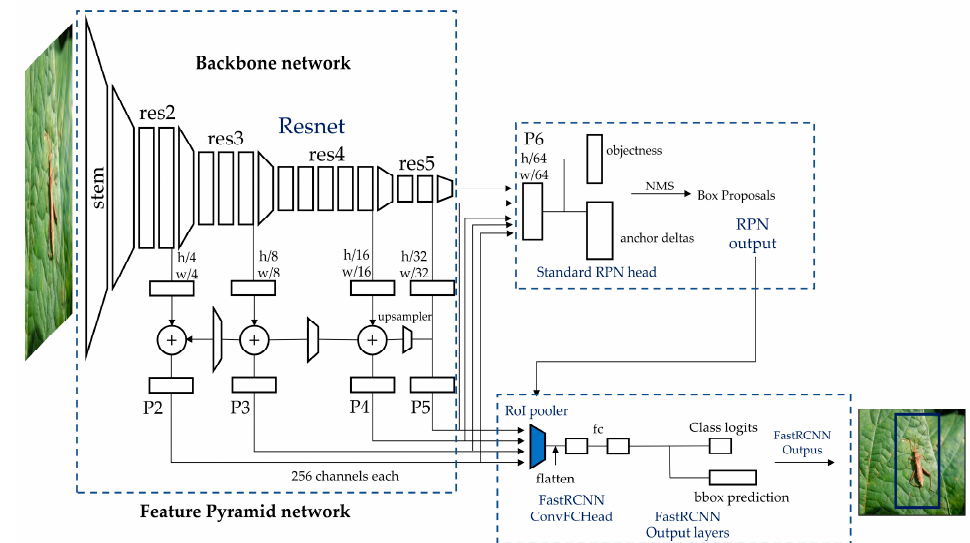
Figure 4. Detectron2 architecture. Detectron2 consists of a Feature Pyramid Network (FPN), Region Proposal Network, RoI Heads, and RoI pooler. Extracts feature maps from input image at different scales and detect object regions from the multi-scale features.